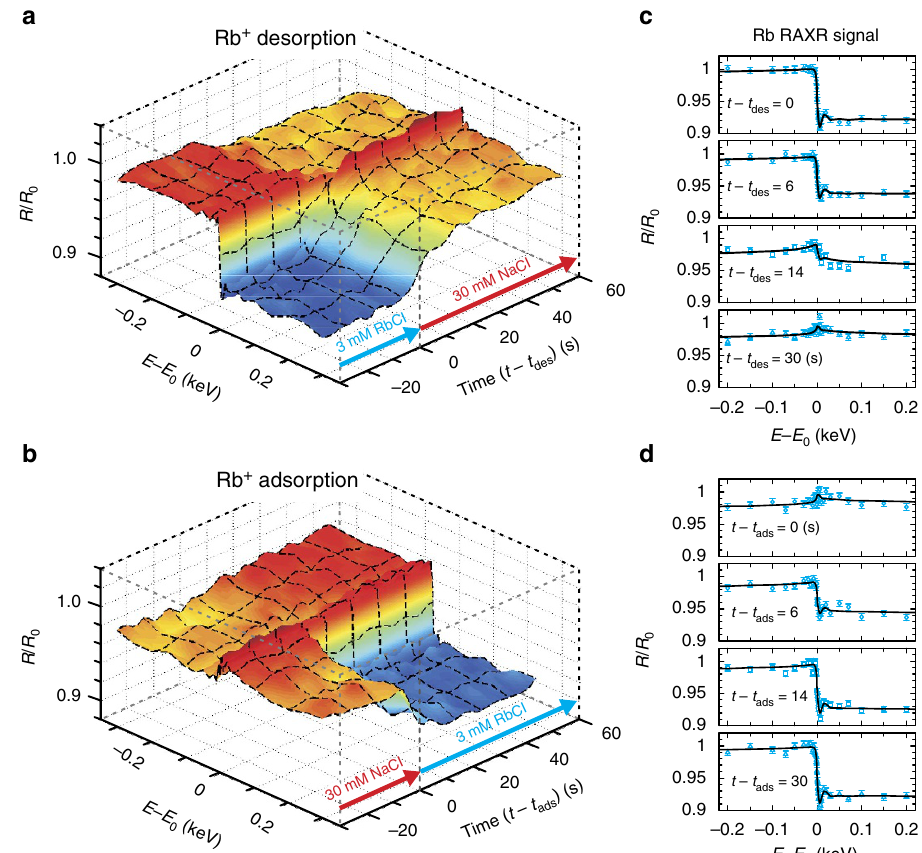
Figure 3 | TRAXR at the muscovite mica (001)–water interface. X-ray reflectivity during Rb þ desorption ( a ) and adsorption ( b ) was measured as a function of photon energy ( D E ¼ E (cid:2) E o ) and reaction time ( D t ¼ t (cid:2) t des or t (cid:2) t ads , respectively). ( c , d ) TRAXR spectra sampled at four different delay times after solution exchange during Rb þ desorption or adsorption. Error bars (s.d.) are derived on the basis of the counting statistics 43